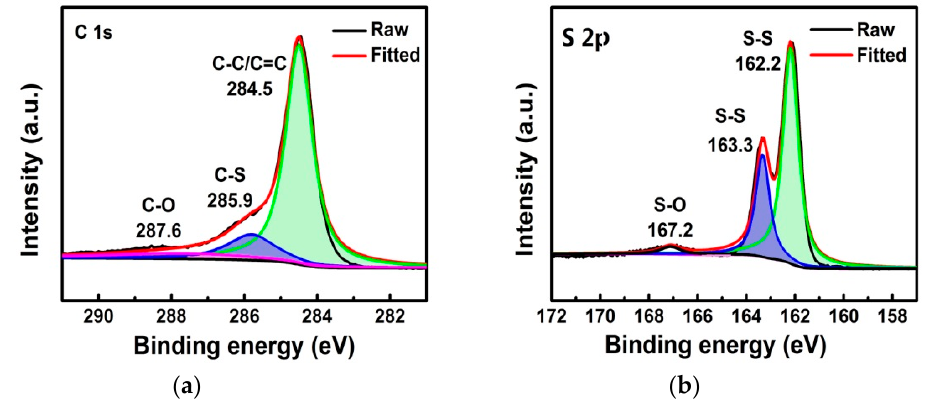
Figure 6. XPS spectra of S/GO for ( a ) C 1s and ( b ) S 2p peaks.